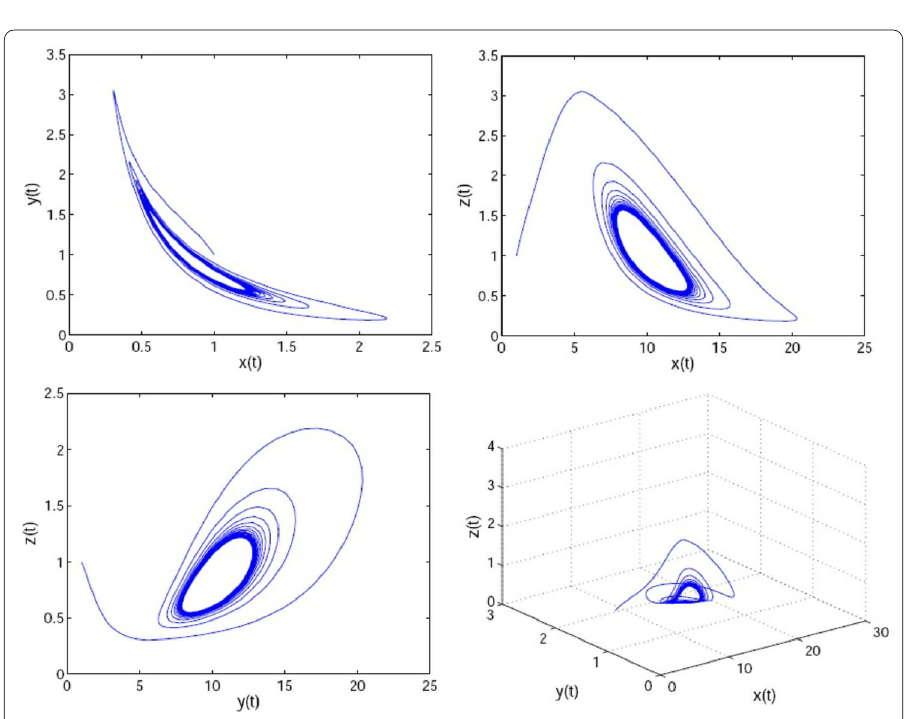
Figure 4 The phase plots of system (31). It is unstable with τ = 7 > τ 0 =